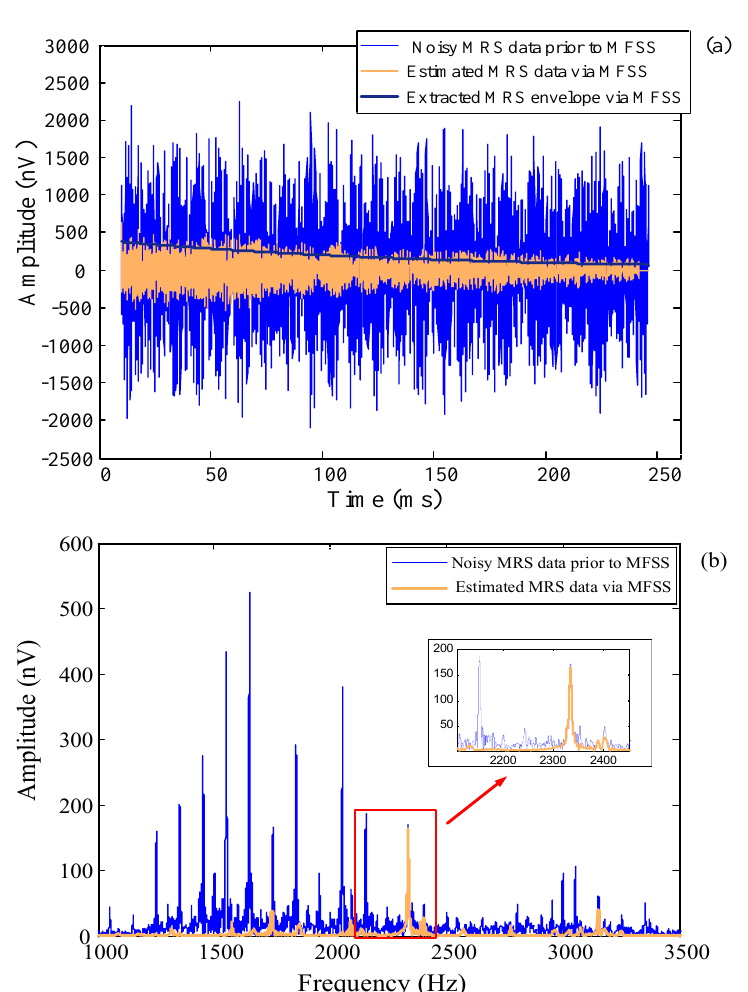
Figure 12. Noise reduction of field MRS data by MFSS under the condition of long frame length and large sliding distance. ( a ) The waveform comparison and the extracted envelope; ( b ) the spectral amplitude comparison.